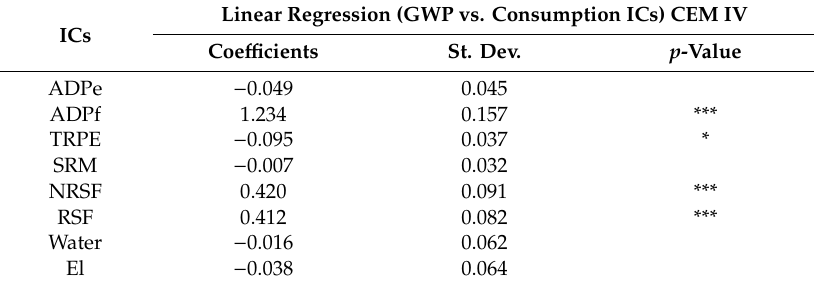
Table 11. Linear regression summary (GWP vs. Consumption ICs)—CEM